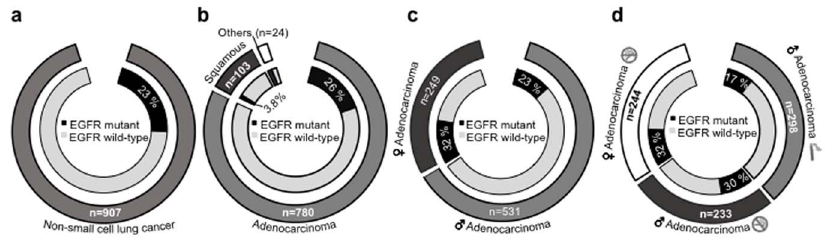
Figure 1. EGFR (exon 18–21) mutation status among NSCLC patients in India. (A) EGFR mutation status across all NSCLC samples is shown. Black segment in the inner circle indicate patients harboring EGFR mutation, the segment in white indicates patients with wild type EGFR . The segment in grey (outer circle) indicates total number of NSCLC patients. (B) EGFR mutations across different histological subtypes. Grey segment in the outer circle indicate total number of lung adenocarcinoma patients. The patients with squamous histology are represented in dark grey. The segment in white represents lung cancer patients with tumors histology other than adeno or squamous carcinoma. Similar to (A), the black segment in the inner circle indicate patients harboring EGFR mutation, the segment in white indicates patients with wild type EGFR .(C) EGFR mutation variation among male and female lung adenocarcinoma patients. The light grey slice represents male patients; female lung adenocarcinoma patients represented in dark grey in outer circle. Similar to (A), the black segment in the inner circle indicate patients harboring EGFR mutation, the segment in white indicates patients with wild type EGFR among male and female lung adenocarcinoma patients. (D) EGFR mutation variation with respect to gender specific smoking habits among all lung adenocarcinoma patients. Light grey segment in the outer circle indicate male adenocarcinoma lung cancer patients with smoking history. The non smoker male and female lung adenocarcinoma patients are represented in dark grey and white, respectively. The segment in white represents lung cancer patients with tumors histology other than adeno or squamous carcinoma.